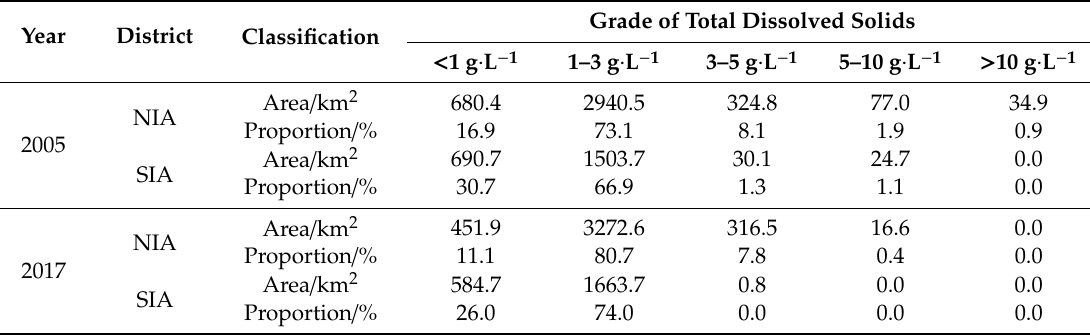
Table 3. Classification area and proportion of groundwater TDS in the Yinchuan